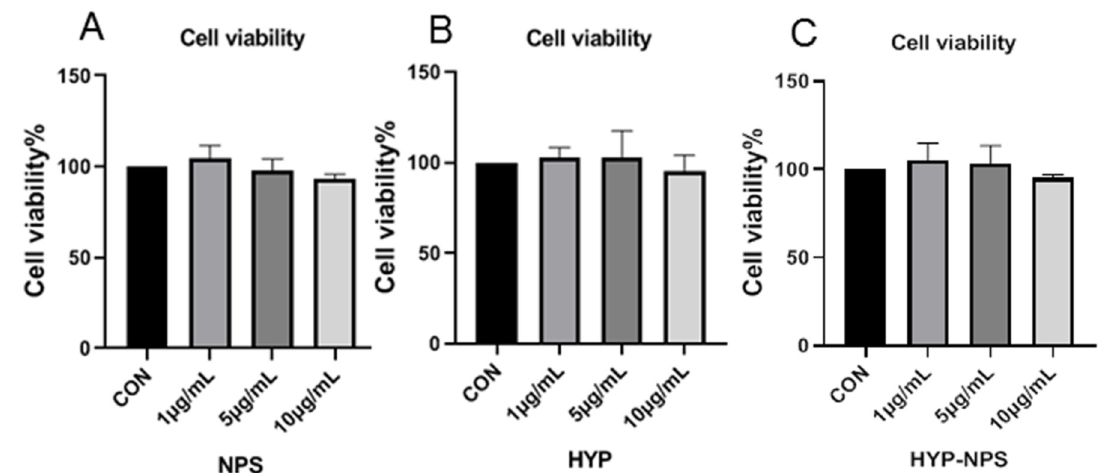
Figure 3. Biocompatibility assessment of NPS, HYP, and HYP-NPS.